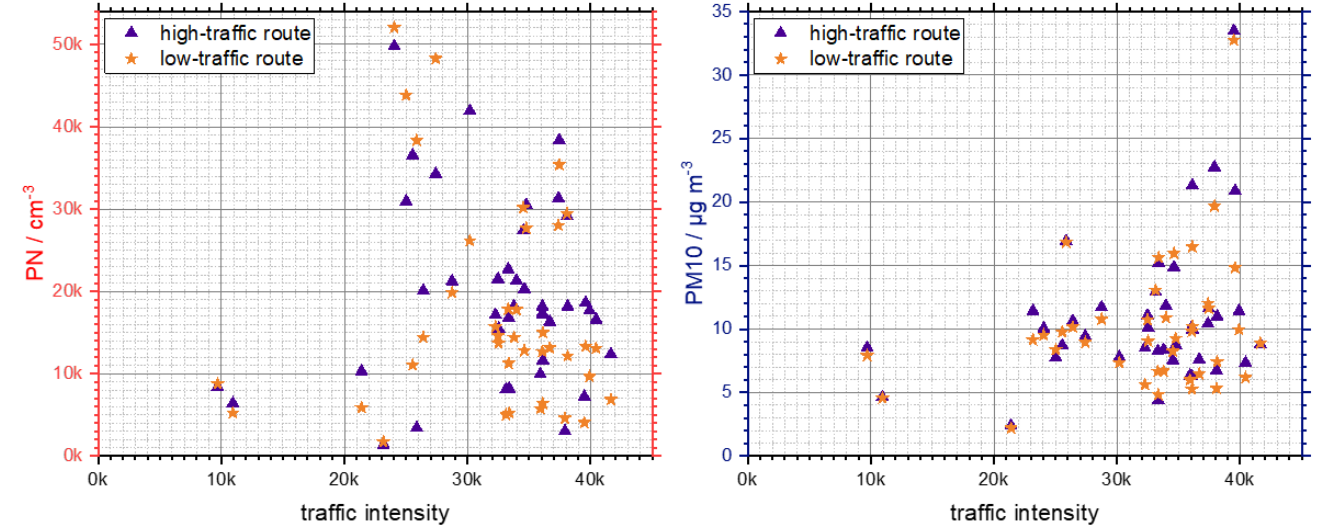
Figure 6. Medians of PN ( left panel ) and PM10 ( right panel ) on both routes plotted against the traffic intensity during the 40 rides. Traffic intensity (counts per hour) refer to the total of 23 intersections close to the bike routes during riding times. Purple triangles show high-traffic route medians; orange stars show low-traffic route medians.